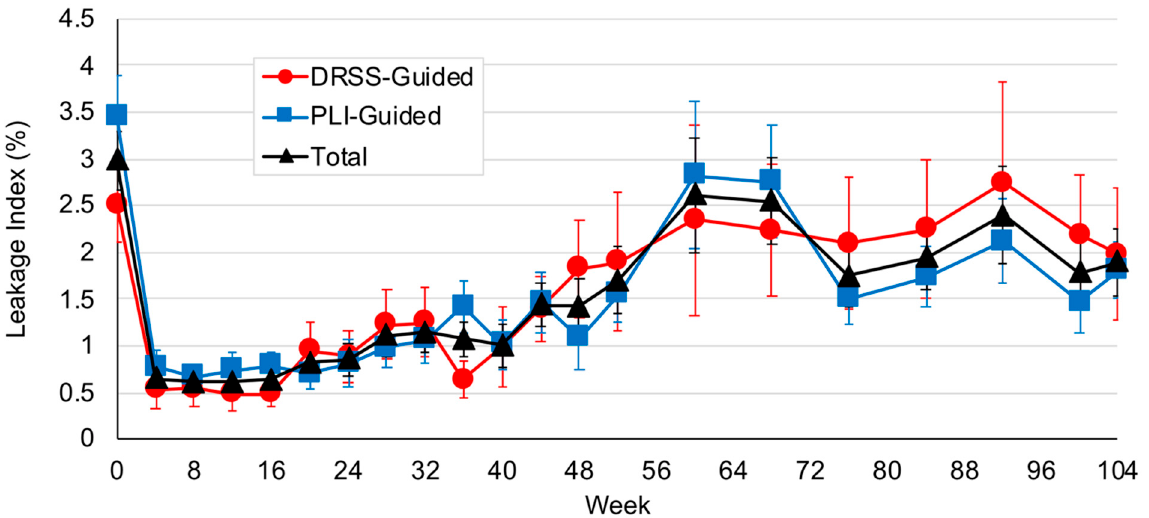
Figure 4. Panretinal leakage index (PLI) in through week 104. Mean PLI decreased by 11% ( p = 0.73) and 23.6% ( p = 0.25) compared to baseline in the diabetic retinopathy severity scale (DRSS)- and PLI-guided arms, respectively.